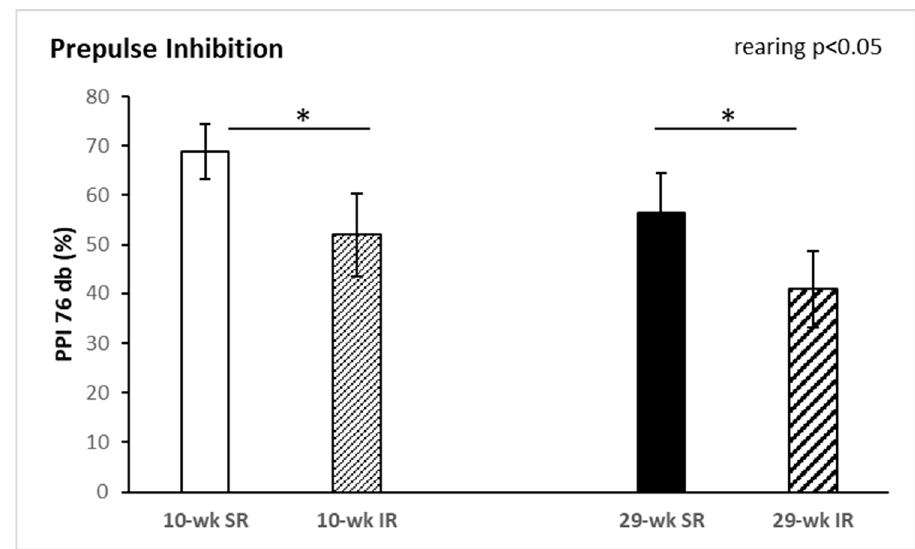
Figure 1. Effects of isolation rearing conditions on pre-pulse inhibition at 76 dB level. 10–wk SR, 10 week socially reared SD rats; 10–wk IR, 10 week isolation reared SD rats; 29–wk SR, 29 week socially reared SD rats; 29–wk IR, 29 week isolation reared SD rats; SD, Sprague Dawley; PPI, pre-pulse inhibition. Data are expressed as the mean ± SEM. Statistical significance as revealed by two-way ANOVA with subsequent Sidak post-hoc test when appropriate: * p < 0.05.